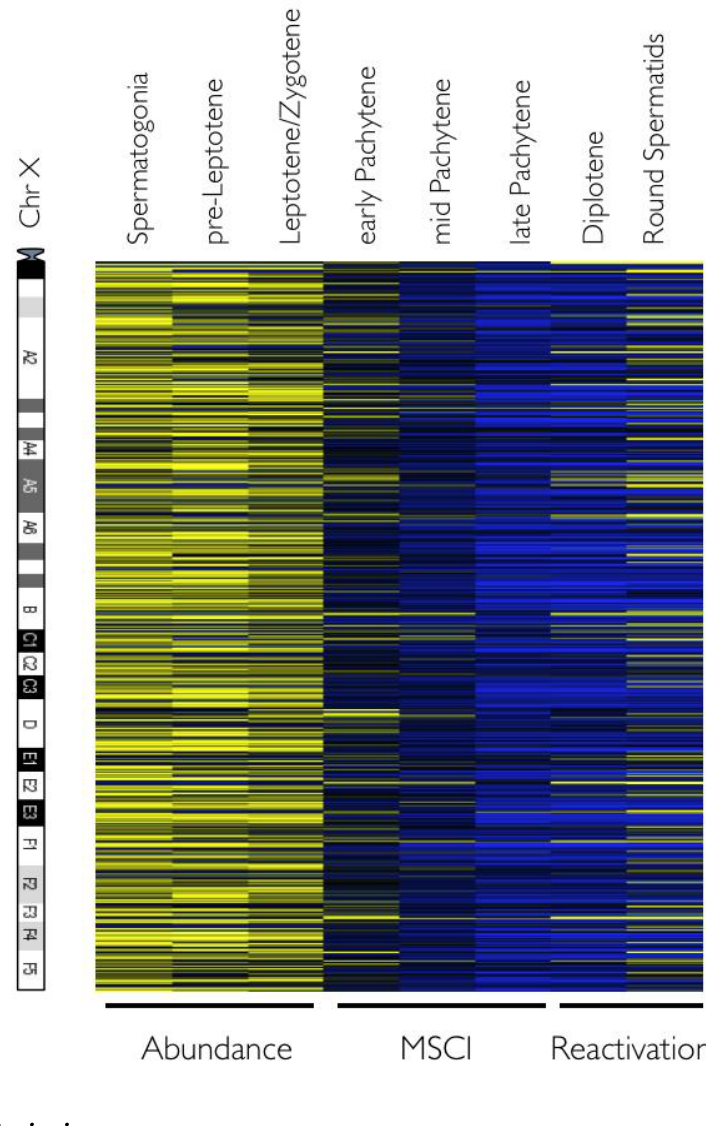
Figure 3. Meiotic sex chromosome inactivation and reactivation. The average expression of 874 X-linked present probe sets is shown. Complete inactivation is clearly visible at the late pachynema stage. The three phases of chr X meiotic developmental stage are indicated below the heatmap. Probe sets were serially ordered relative to their chromosome location from centromere to telomere but are not to scale. A schematic of chr X is shown on the left for orientation